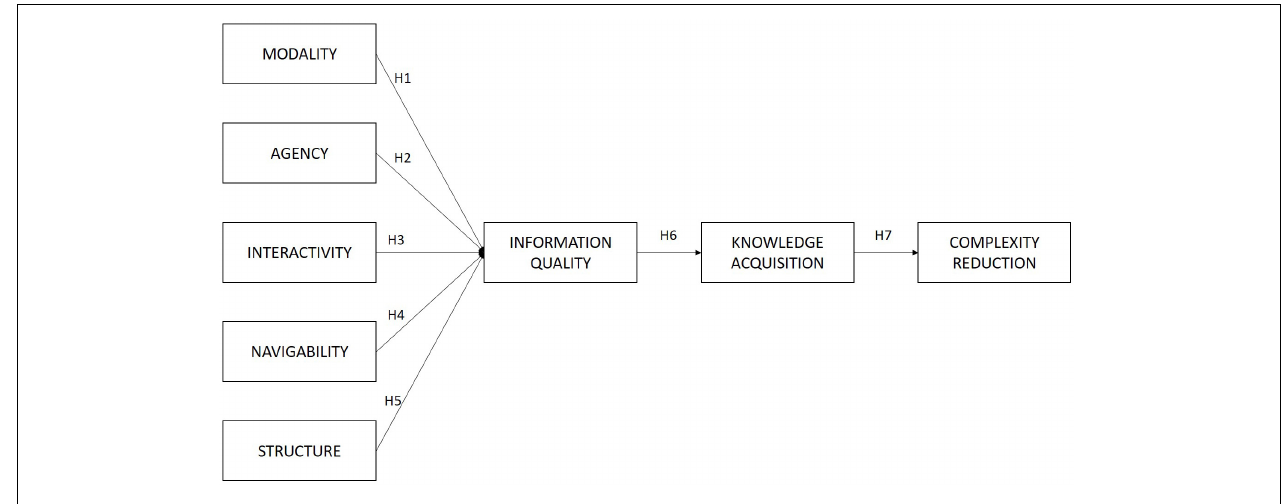
FIGURE 1 | Theoretical framework of the